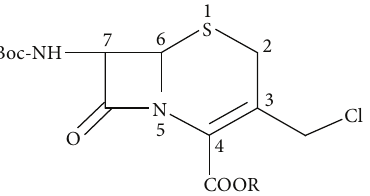
Figure 1: General structure of 3-chloromethyl